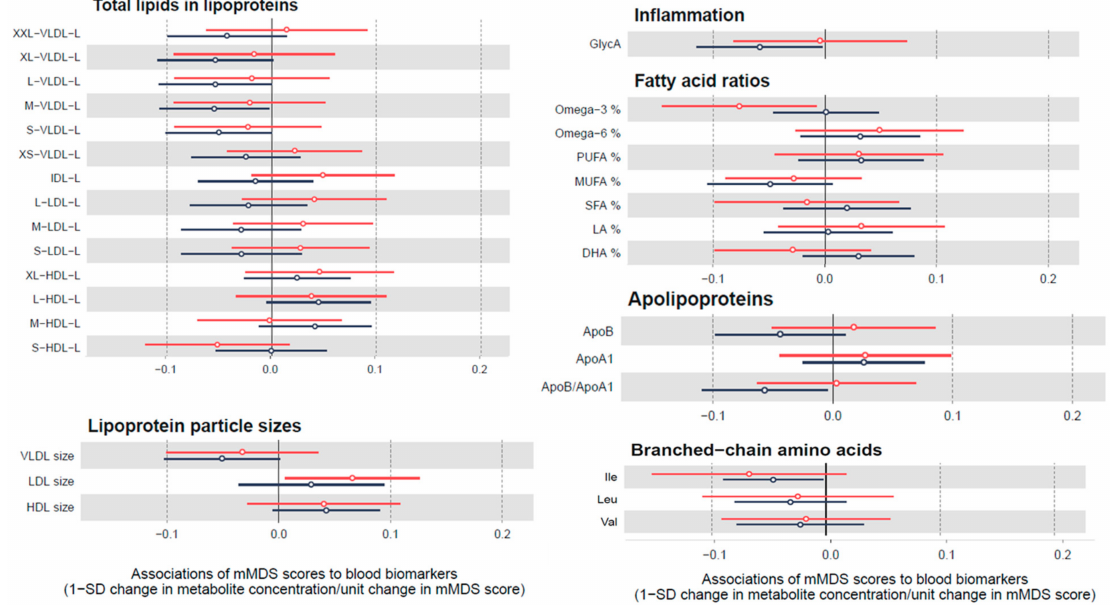
Figure 3. Cross-sectional association between biomarkers and adherence to the MedDiet for all participants at time point 1 and time point 2. Red lines show the results for the participants at baseline and black lines for the participants at follow up. Results show changes by SD in each biomarker per unit change in mMDS score and are displayed by hollow points along with their 95% confidence